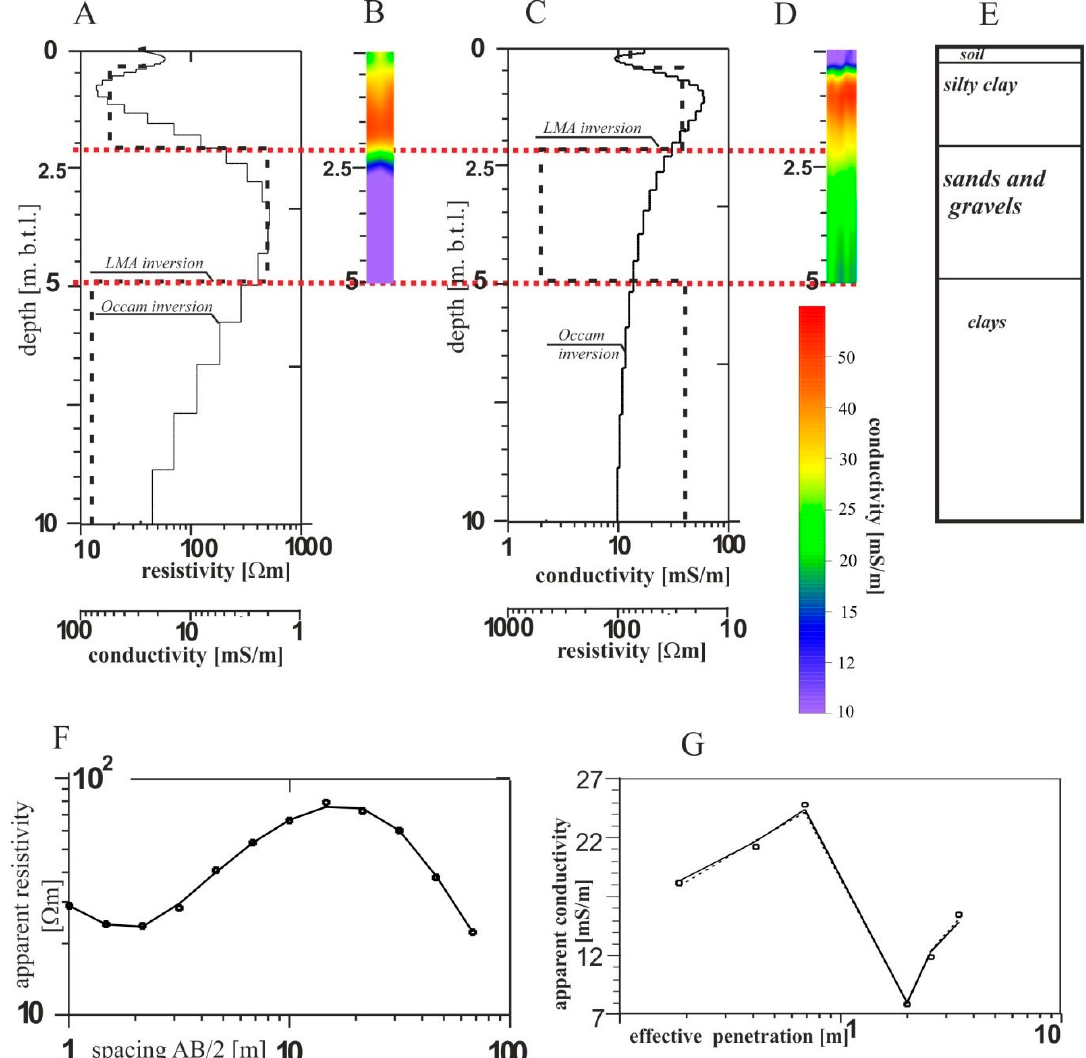
Figure 4. Results of an interpretation of location No. 1 (Figure 1) incorporating both the DC and GCM soundings and using IX1D software, A —geoelectric models obtained from the DC resistivity soundings, B —conductivity section of the DC data (for short array profiling), C —geoelectric models obtained from the GCM soundings, D —conductivity section of the GCM data (for short array profiling), E —borehole data, F —fit between the measured DC data and calculated DC data, G —fit between the measured GCM data and calculated GCM data. Correlation of the silty clay layer identified by the DC sounding and GCM sounding No. 1 ( ).